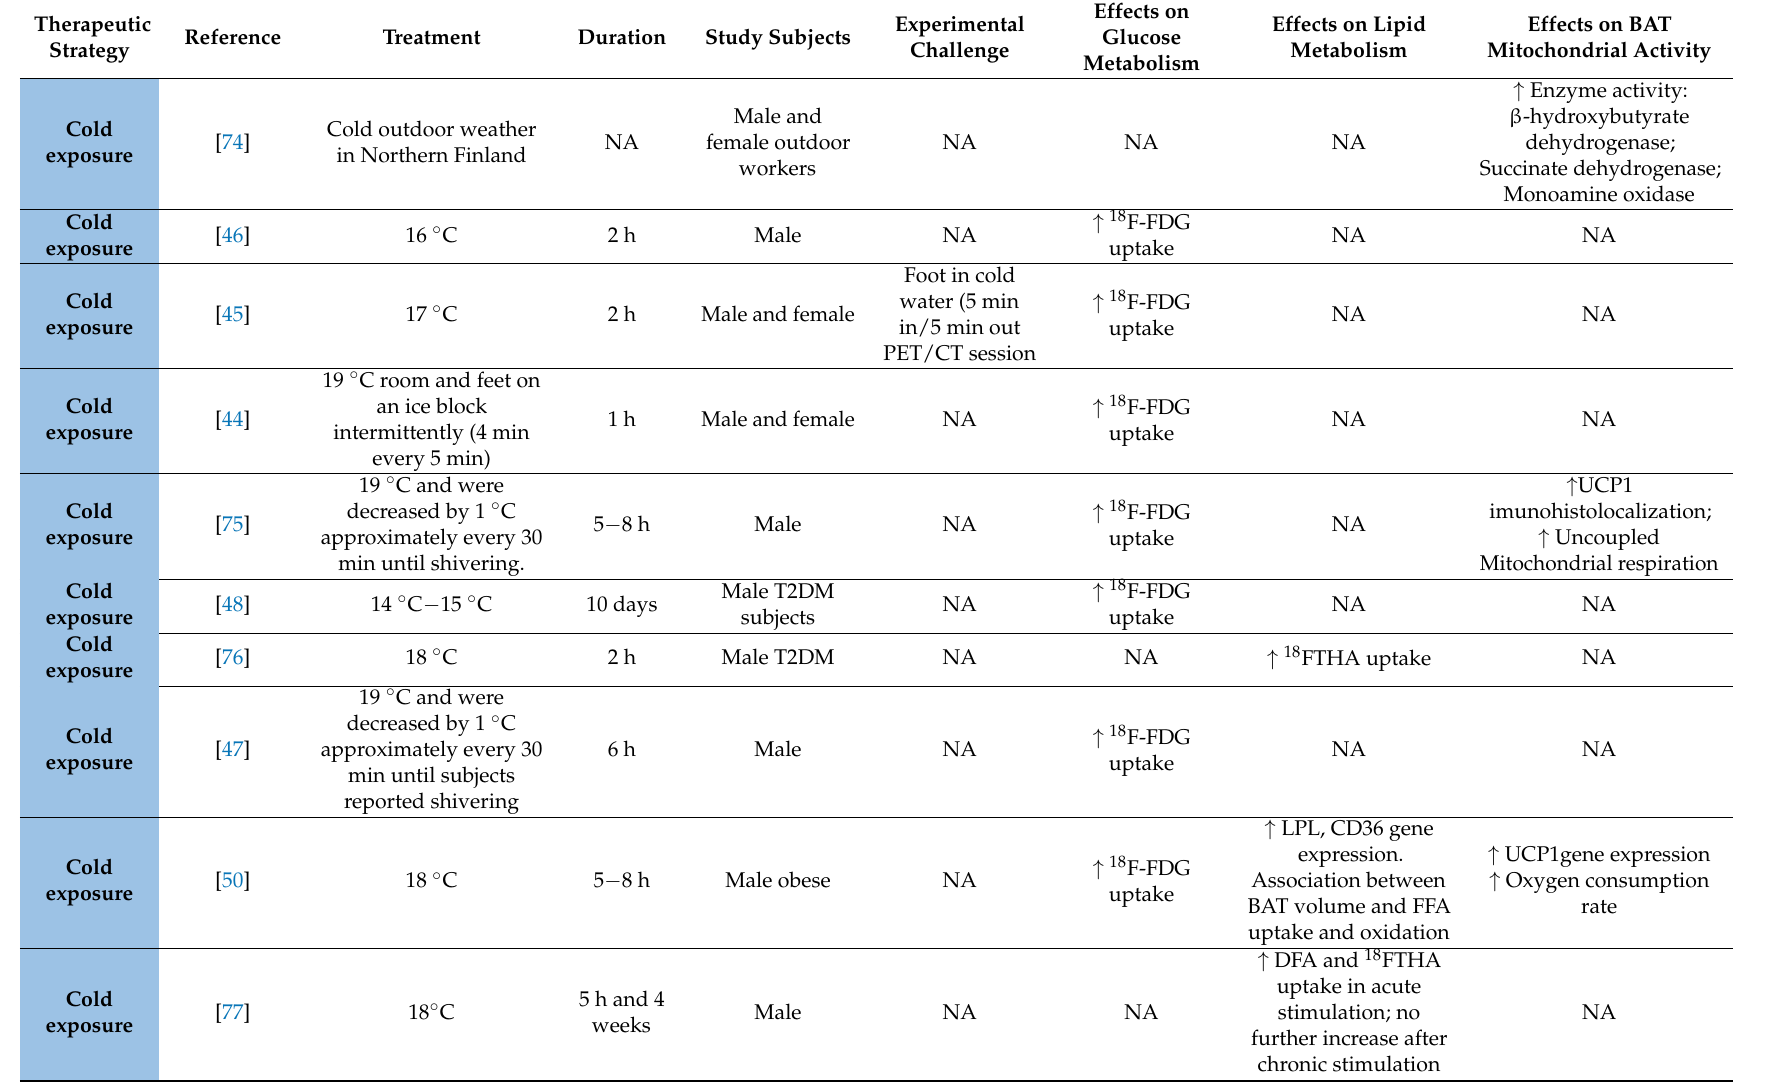
Table 2. Effect of cold and exercise on BAT metabolism in